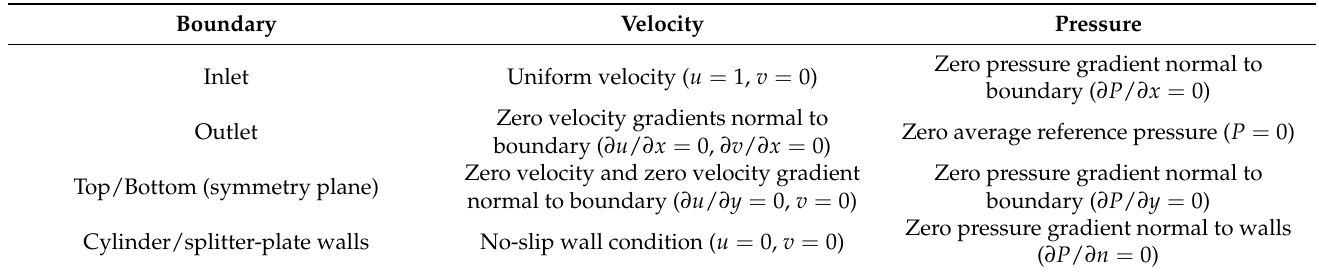
Table 1. Boundary conditions and their corresponding mathematical expressions.